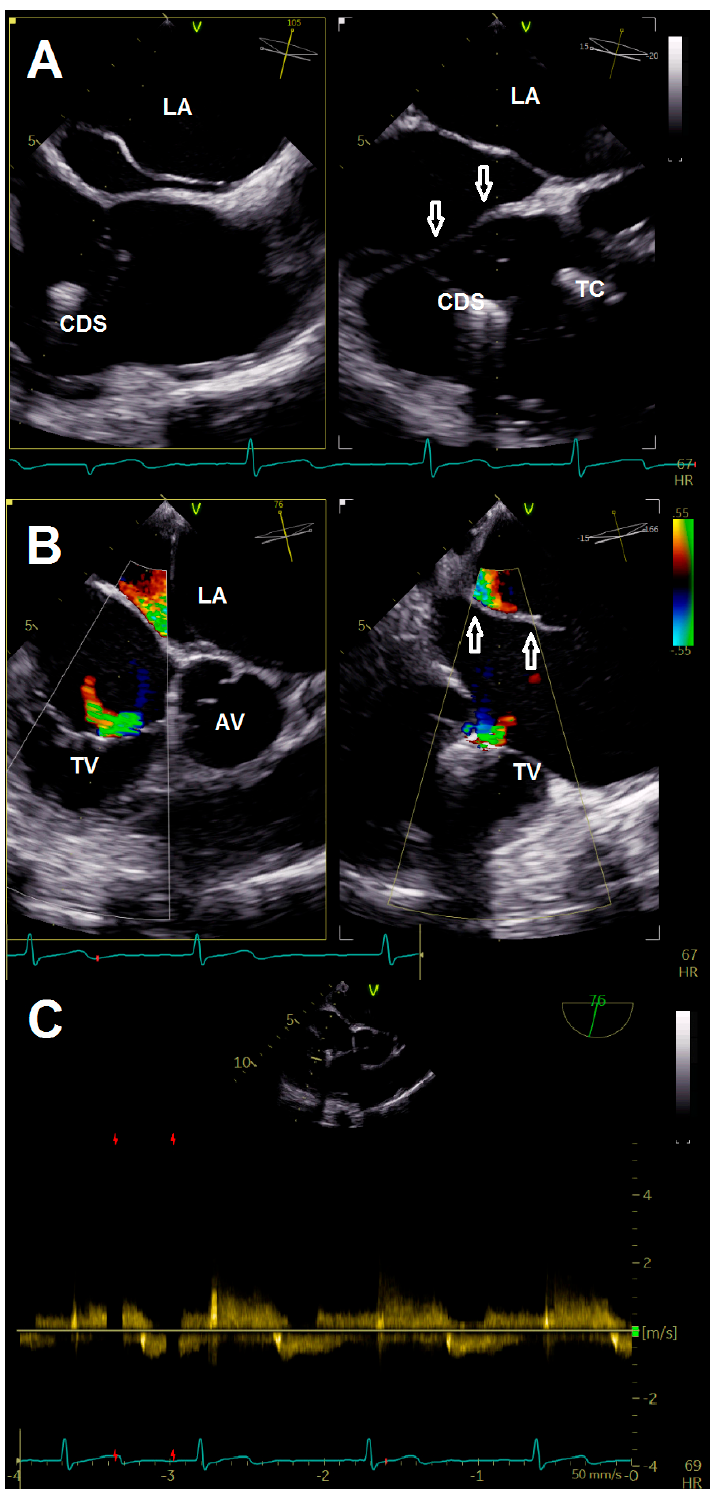
Figure 3. ( A ) Crossing of membrane (arrows) during introduction of the clip delivery system. ( B ) Multiplane color doppler evaluation of tricuspid regurgitation after implantation of three clips. ( C ) Continuous wave doppler after clip implantation showing no relevant tricuspid stenosis. Abbreviations: AV, aortic valve; CDS, clip delivery system; LA, left atrium; TC, TriClip ® ; TV, tricuspid valve.